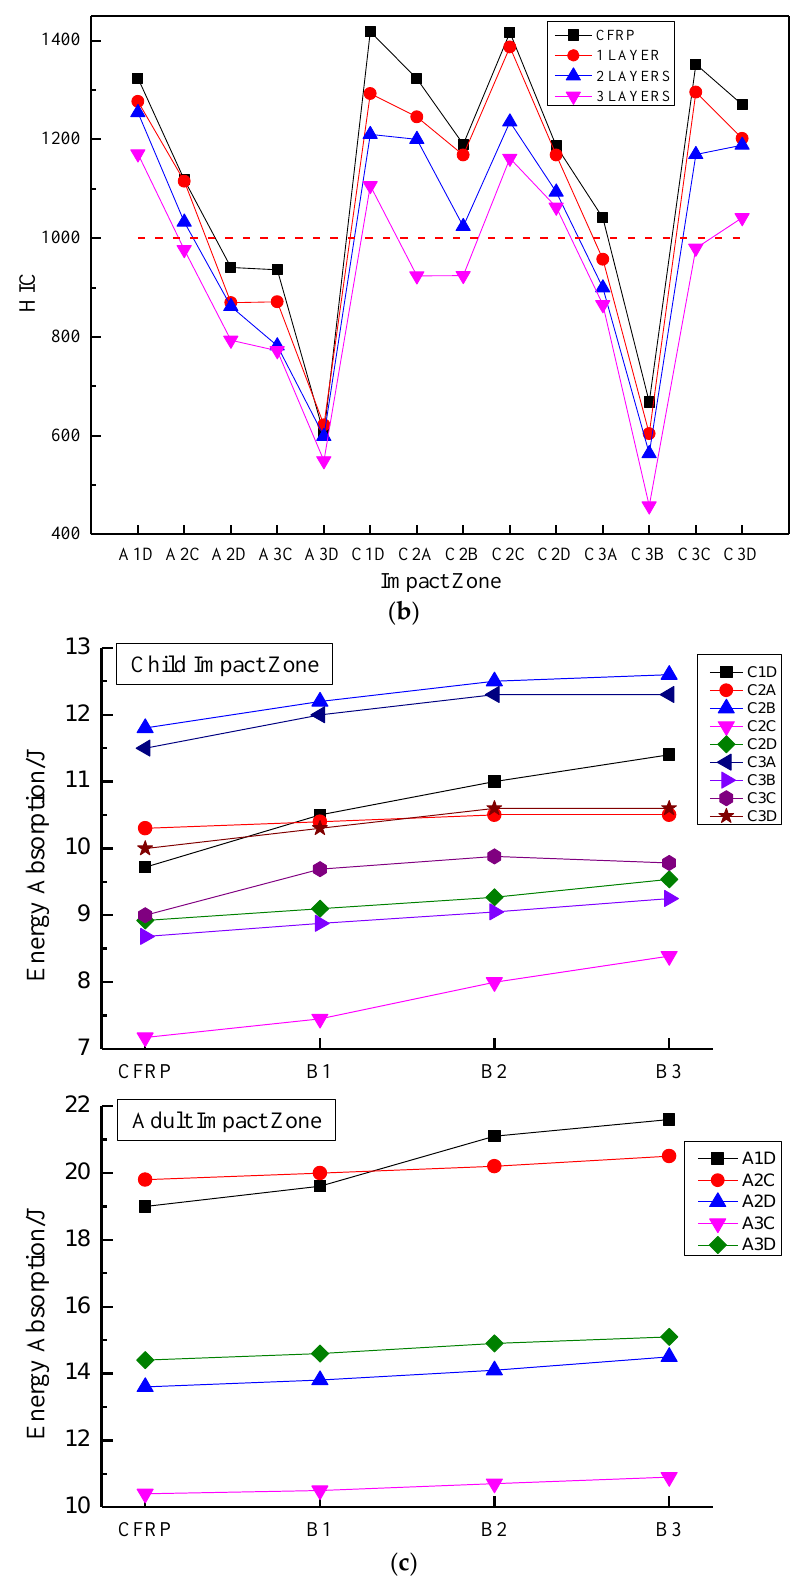
Figure 12. ( a ) head impact zone division, ( b ) HIC values of four different stacking sequences, and ( c ) energy absorption comparison of four different stacking sequences.